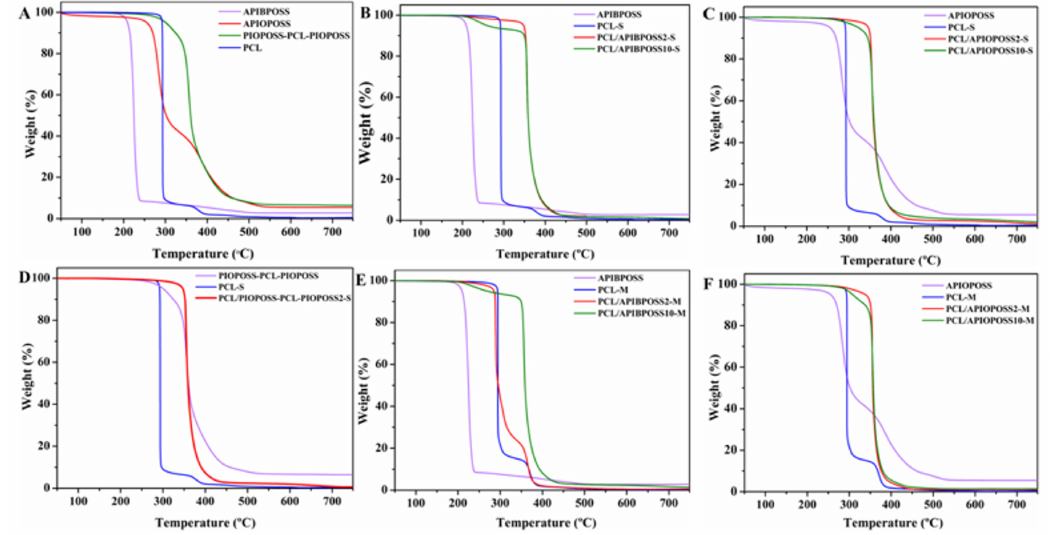
Figure 8. TGA curves of: ( A ) nanofillers and neat PCL; ( B – D ), solution blended nanocomposites; ( E , F ) melt mixed nanocomposites in N 2